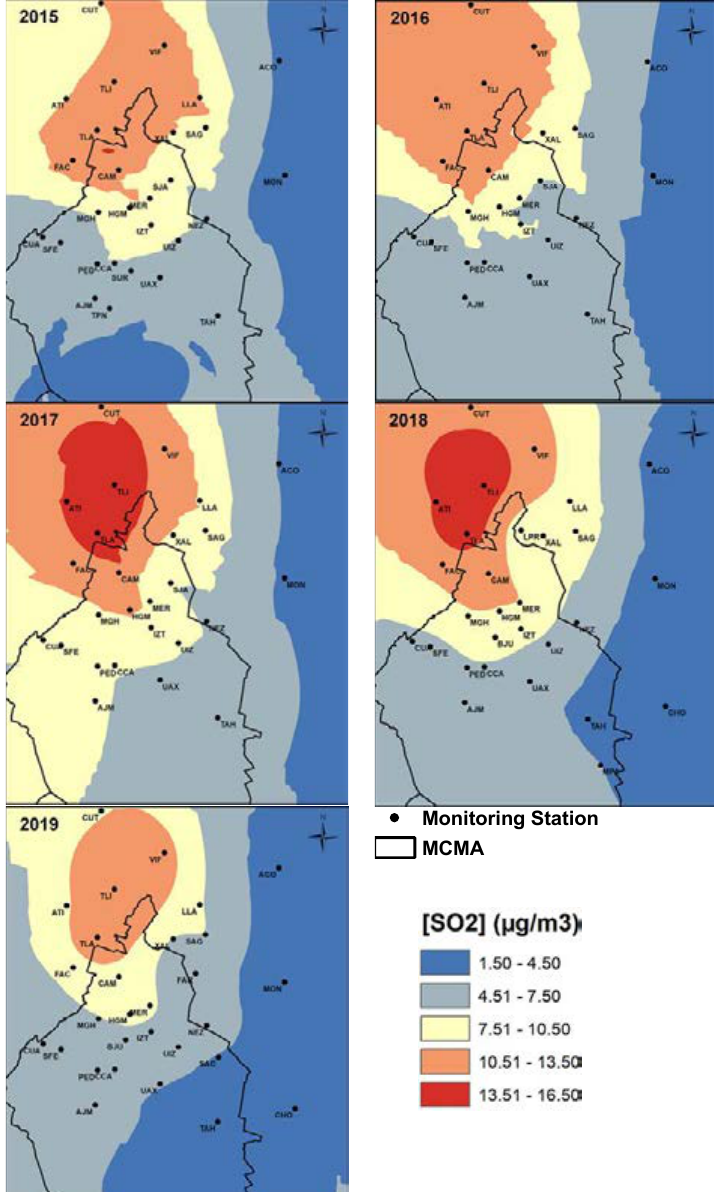
Fig. 2: Maps of concentration layers of the annual average of sulfur dioxide [SO 2 ] (µg/m 3 ) for the period 2015-2019